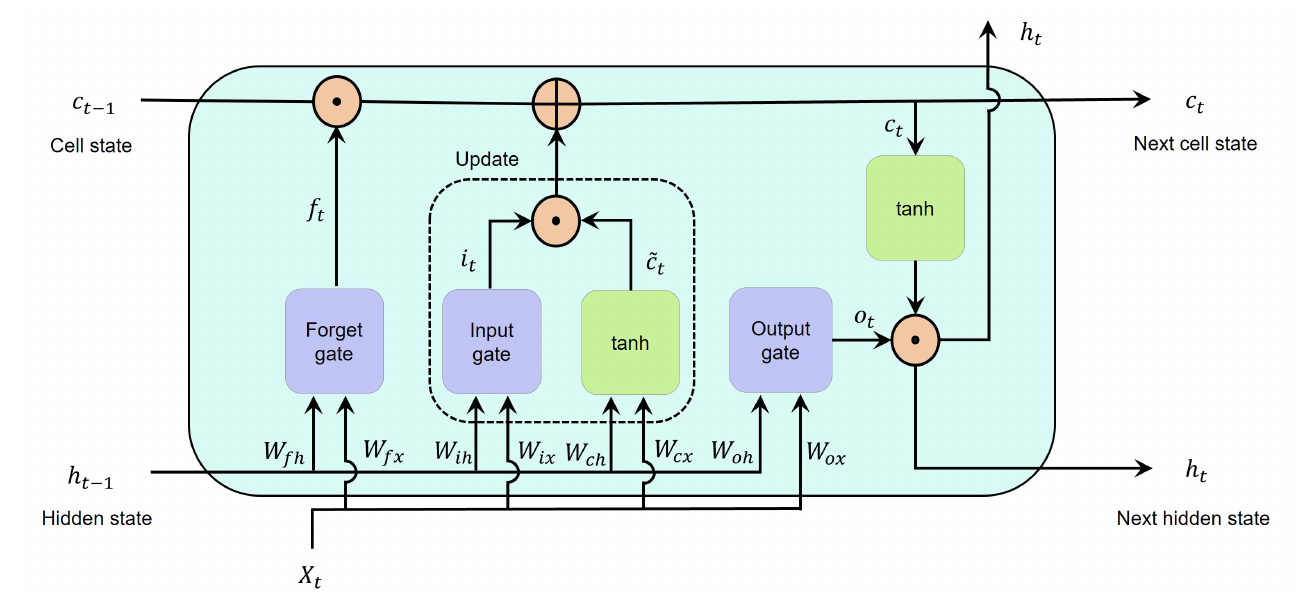
Figure 1. Illustration of an LSTM cell. Note that (cid:12) and ⊕ refer to element-wise multiplication and addition,